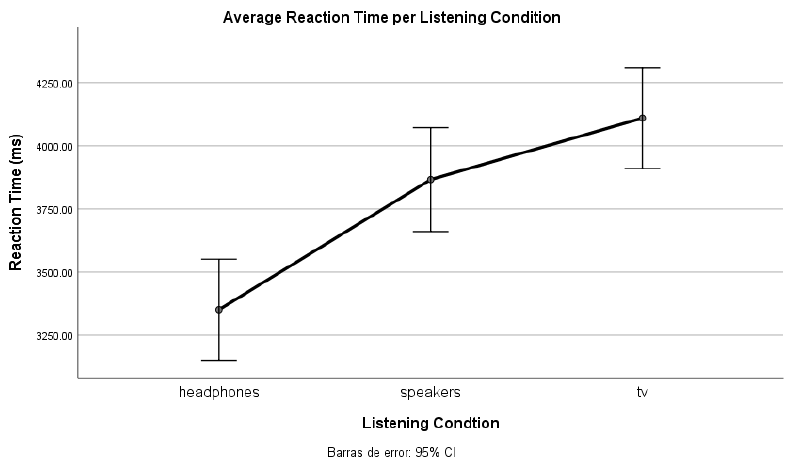
Figure 4. Average reaction time per listening condition.